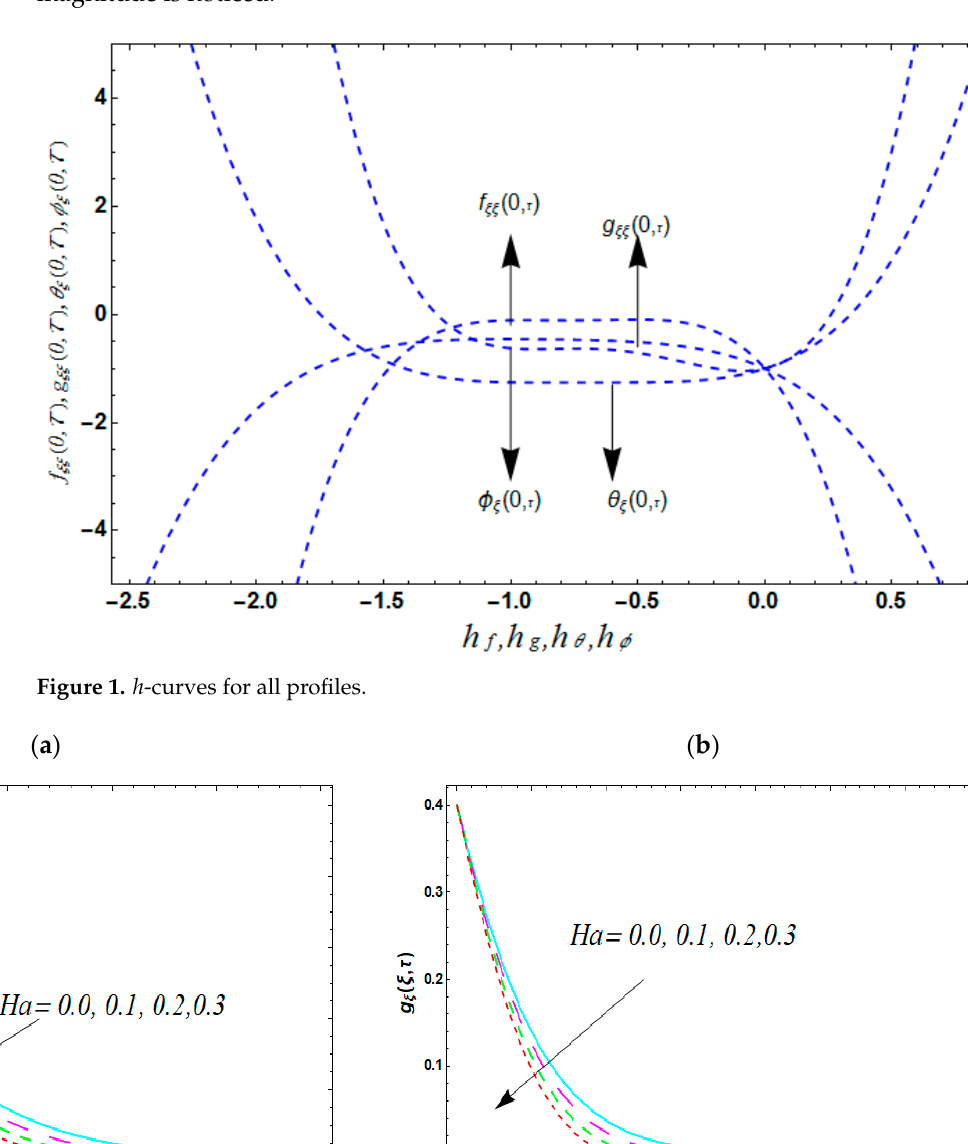
Figure 2. ( a ) Pro fi les of f ξ for various Ha values; ( b ) pro fi les of g ξ for various Ha values. Figure 2. ( a ) Profiles of f ξ for various Ha values; ( b ) profiles of g ξ for various Ha